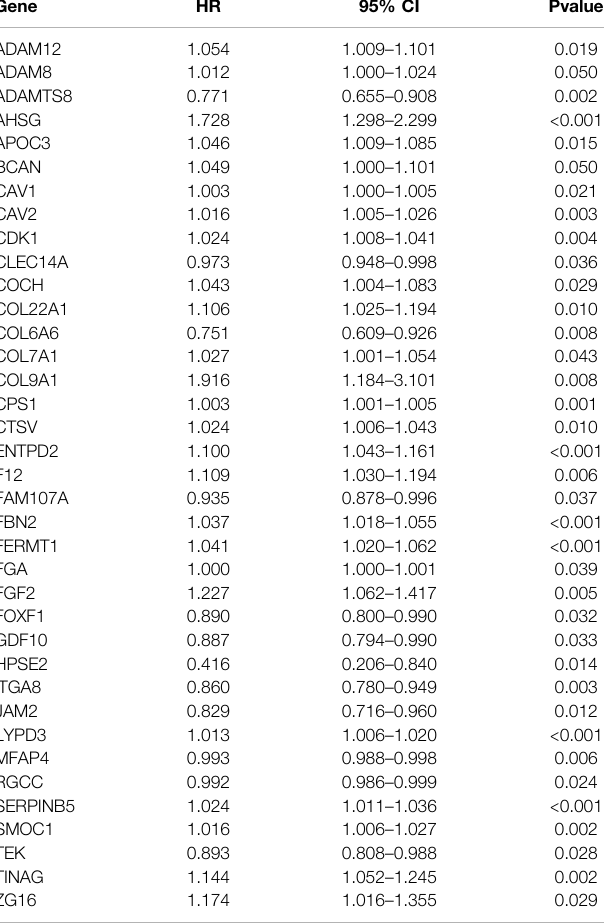
TABLE 1 | Results of univariate cox regression analysis in the TCGA cohort. Gene HR 95% CI Pvalue